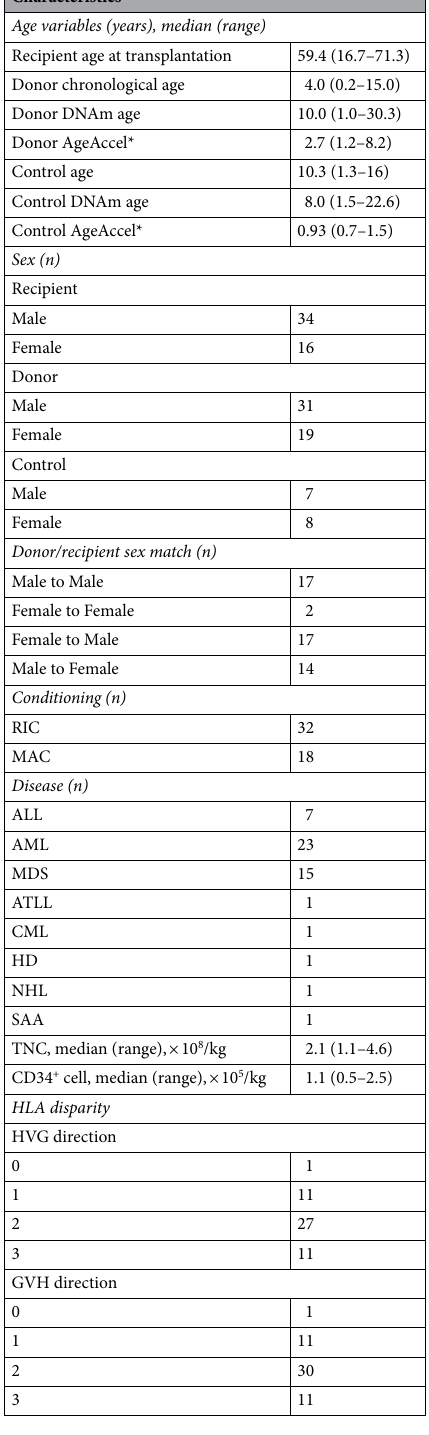
Table 1. Patient and control characteristics. RIC reduced intensity conditioning; MAC myeloablative conditioning; ALL acute lymphoblastic leukemia; AML acute myeloid leukemia; MDS